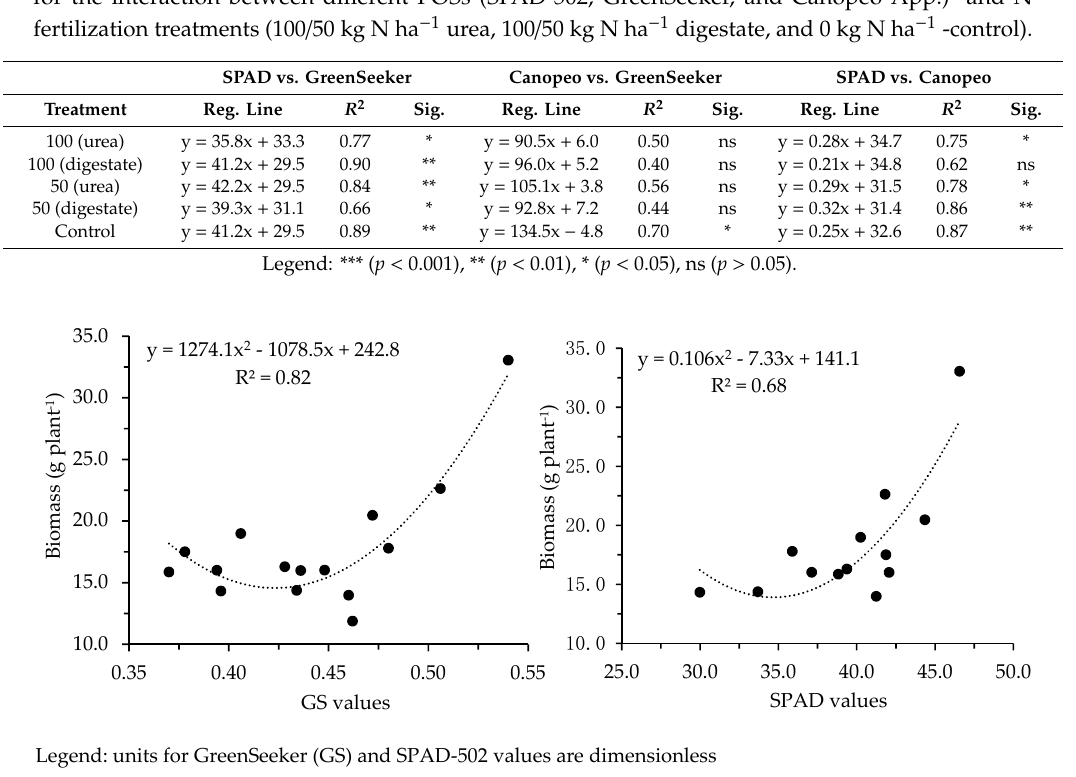
Table 3. Lineal regression, coefficient of determination (R 2 ), and statistical hypothesis testing ( p -value) for the interaction between different POSs (SPAD-502, GreenSeeker, and Canopeo App.) and N